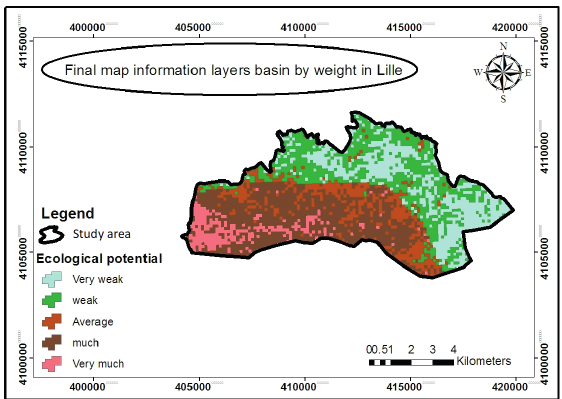
Figure 5 - Map of the re-classification of overlay of the criteria of Lille Basin using AND model.